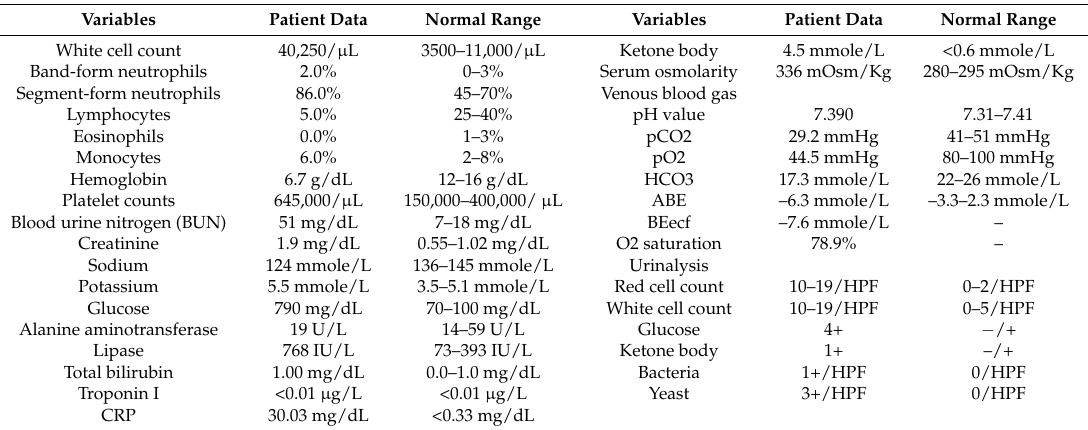
Table 1. The laboratory evaluation in the